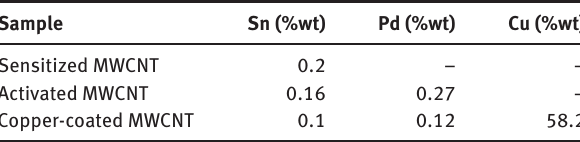
Table 2: Concentration of metal particles deposited on MWCNTs in sensitization, activation, and electroless copper deposition